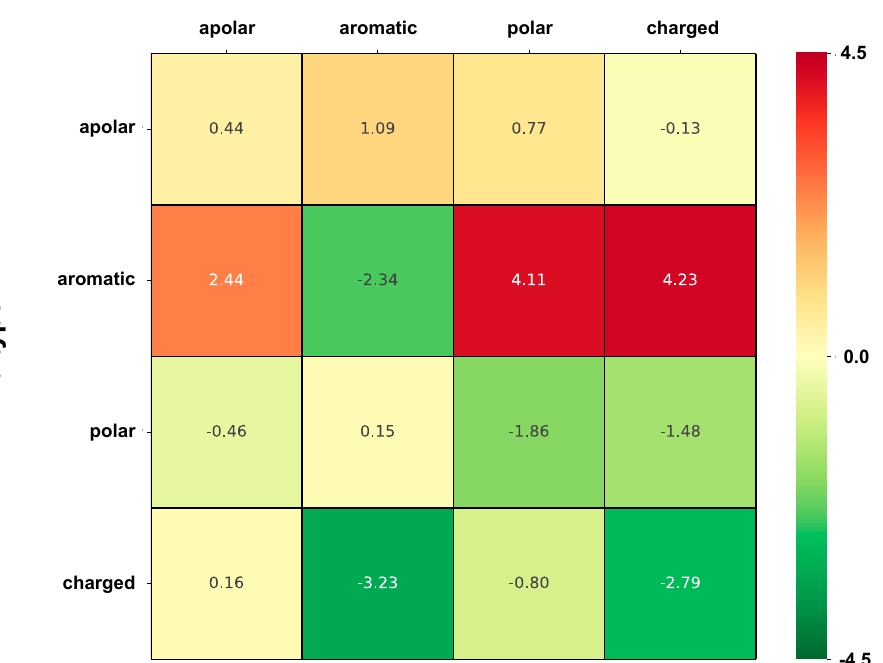
Figure 3. Heatmap shows the strength of association to perturbation (Log-odd) of variation types grouped according to chemico-physical properties of lateral side chains. Residues are grouped as following: apolar (GAVPLIM), aromatic (FWY), polar (STCNQH), charged (DEKR). The color code spans from green (variant types most frequent in the non-perturbing set) to red (variant type most frequent in the perturbing set). Estimated average standard error on reported values is 0.17. Two main outliers can be identified: (i) variations from aromatic to polar residues, which are slightly associated to neutral polymorphisms (association strength is –0.08) but strongly associated to perturbation (association strength is 2.44); (ii) variations from charged to aromatic residues, which are moderately associated to disease (association strength is 0.76) but strongly not associated to perturbation (association strength is –3.23). Pearson’s correlation value is 0.59, suggesting, as previously reported [20], that the association of disease related variations to perturbing ones is moderate (Figure 4).